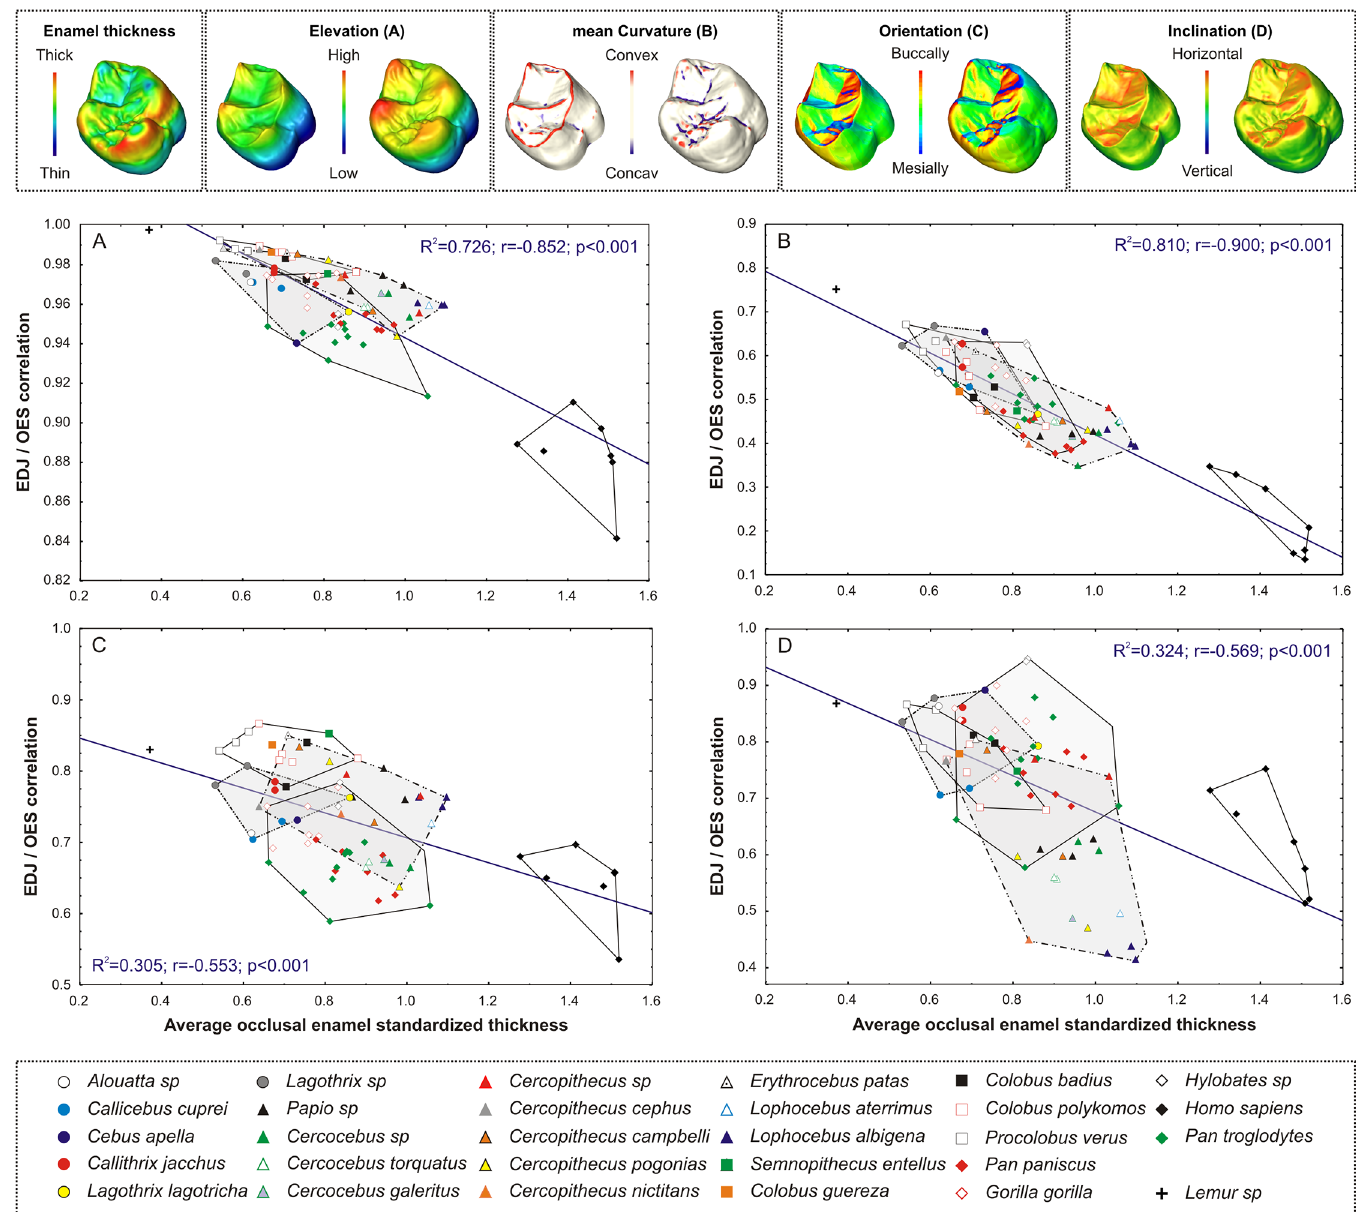
Fig 3. Topometrical individual OES/EDJ correlations relative to average occlusal enamel thickness (mm) of size standardized molars (A) Elevation (B) Mean Curvature (C) Orientation (D) Inclination The tridimensional maps (upper row) illustrate OES (right) and EDJ (left) topometrical data and enamel thickness data (left corner box) used for computing correlations (gorilla molar is shown). For visualization purpose, only extreme concave and convex values are shown on Mean Curvature tridimensional maps. Convex hulls delimit respectively platyrrhines (circles), cercopithecoids (triangles), non-human hominoids (diamonds) and modern humans (black diamonds) The coefficients of determination (R2), correlation (r) and p-value are given for each regression line between the EDJ/OES correlation and 3DET STD (blue) 3DET STD , average occlusal enamel thickness of size standardized